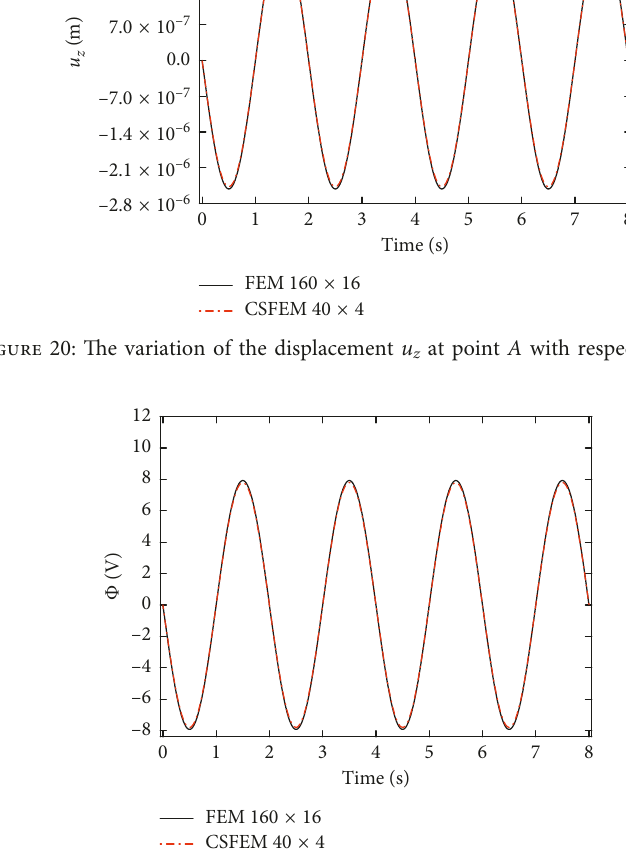
Figure 21: The variation of the electrical potential V at point A with respect to time.